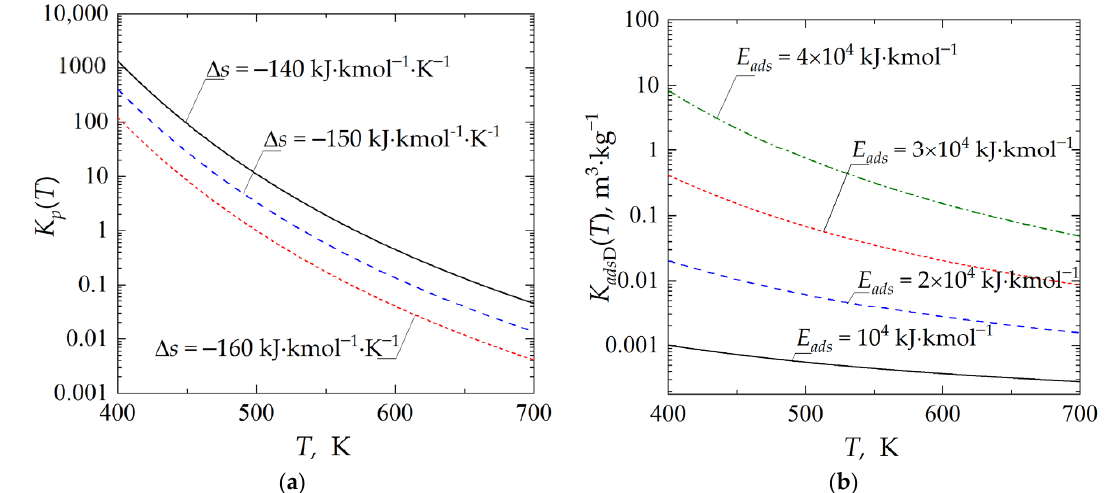
Catalysts 2021 , 11 , x FOR PEER REVIEW Figure 2. Temperature dependence of: ( a ) chemical reaction equilibrium constant, K p ; ( b ) adsorption isotherm constant, K ads D .